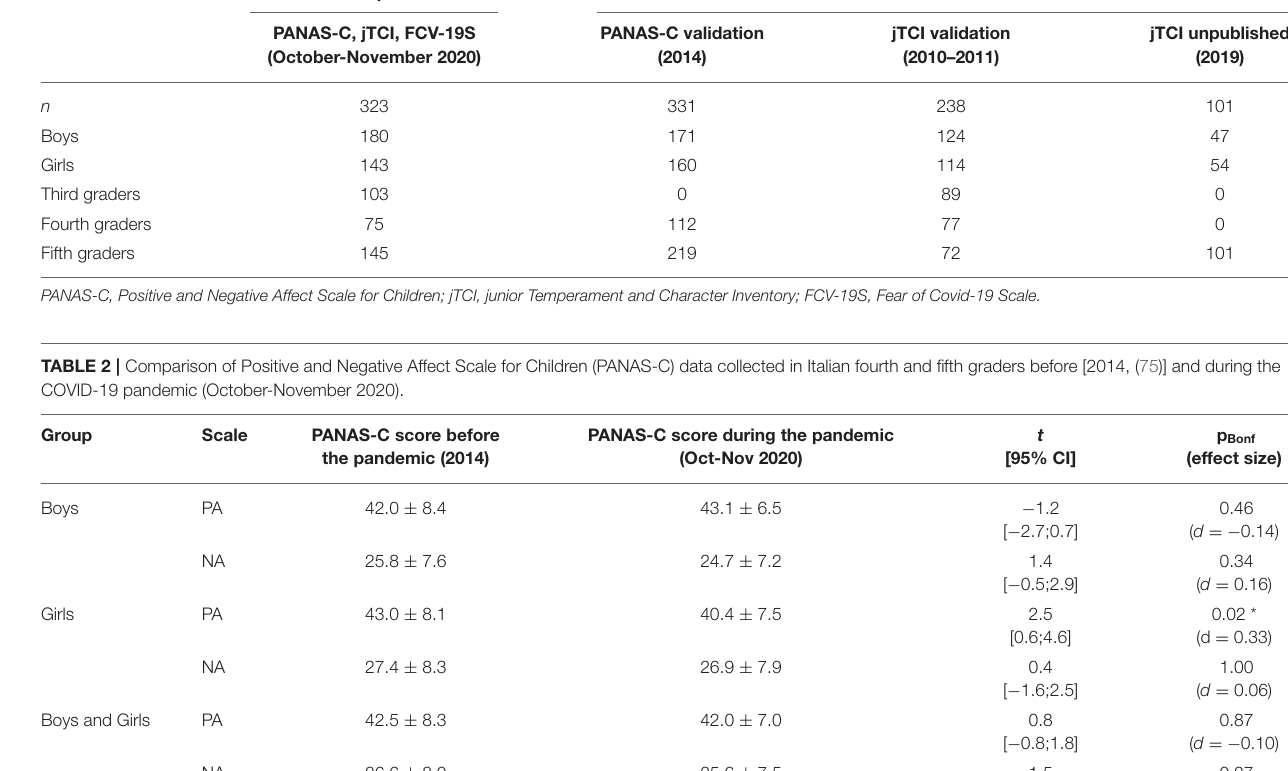
TABLE 1 | Characteristics of the samples used in the study. Sample studied during the COVID-19 pandemic